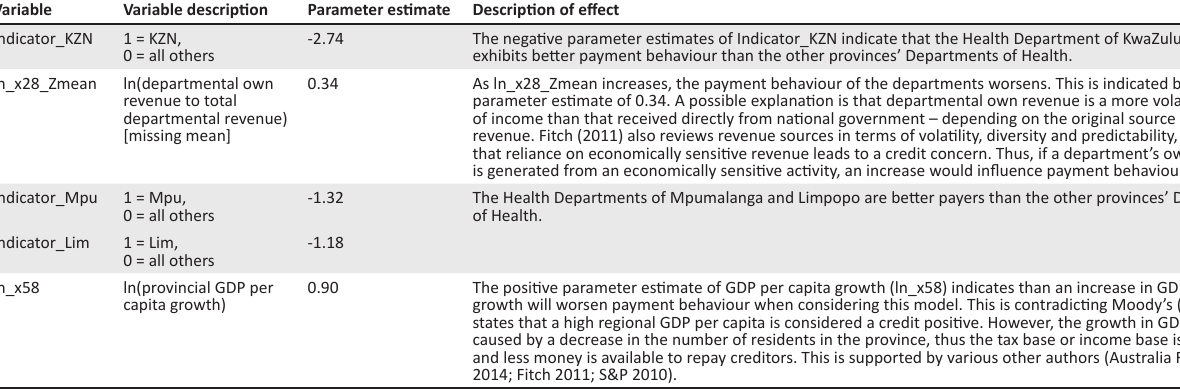
TABLE 3: Details of the Health Basic Model , specifically developed for the Department of Health. Variable Variable